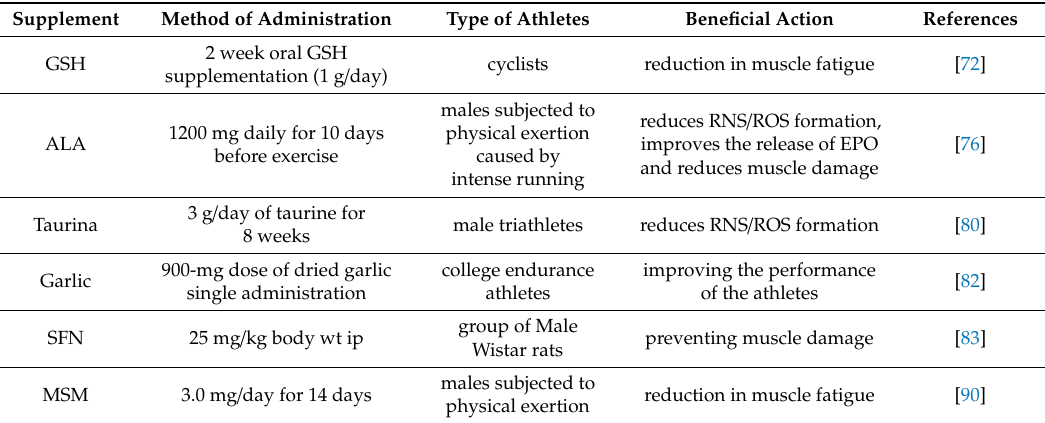
Table 1. Therapeutic e ffi cacy of sulfur-containing compounds in sports